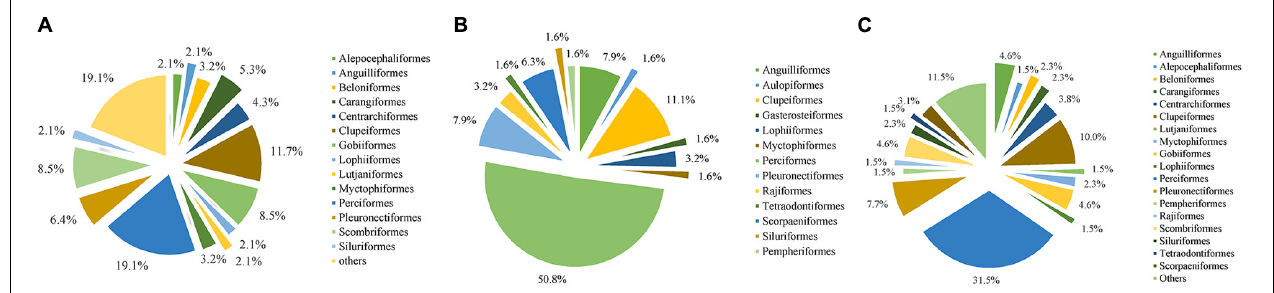
FIGURE 3 | Number of the fish genera according to (A) eDNA metabarcoding and (B) bottom trawling (the dots indicate the number of fish species) in the Zhoushan Sea (China).